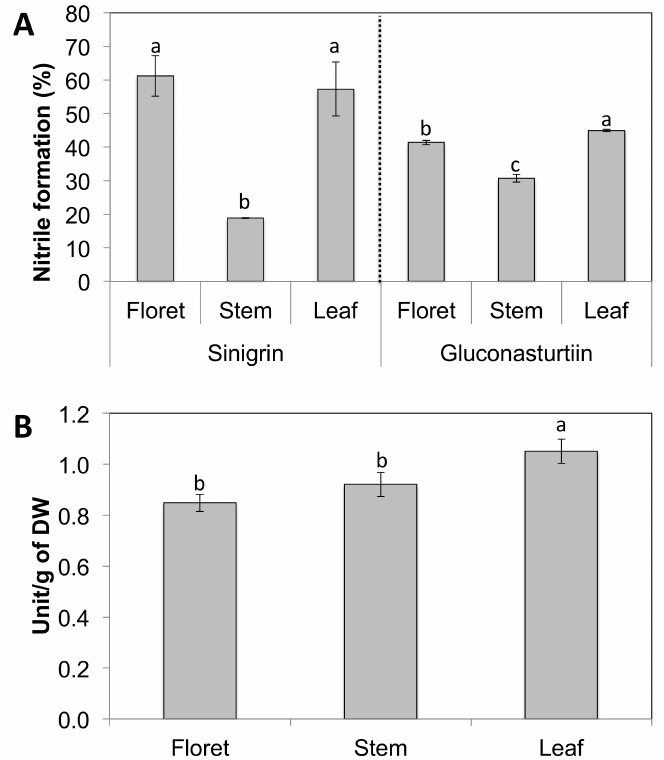
Figure 3. Nitrile formation is shown as the relative ratio of nitrile to the total hydrolysis product formed (sum of isothiocyanates and nitriles). Data are presented as the mean concentration ± standard deviation ( n = 3). Different letters above the error bar indicate significant differences between different tissues within the same glucosinolate substrate by Student’s t -test at p ≤ 0.05. One unit was defined as 1 µ mol of hydrolysis products of glucosinolates released per